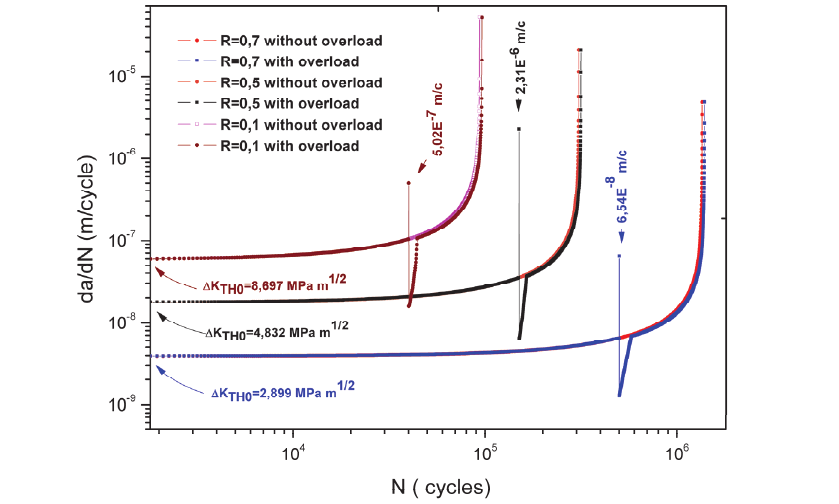
Figure 4: Evolution of the cracking rate as a function of the number of loading